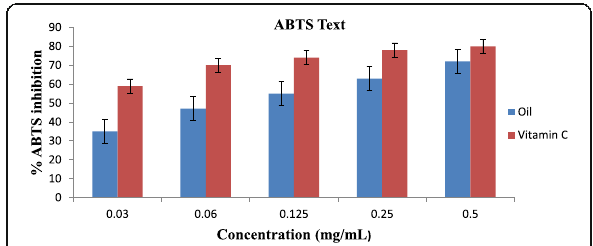
Fig. 3 Antioxidant effect of essential oil of T. minuta flower and vitamin C on ABTS radical